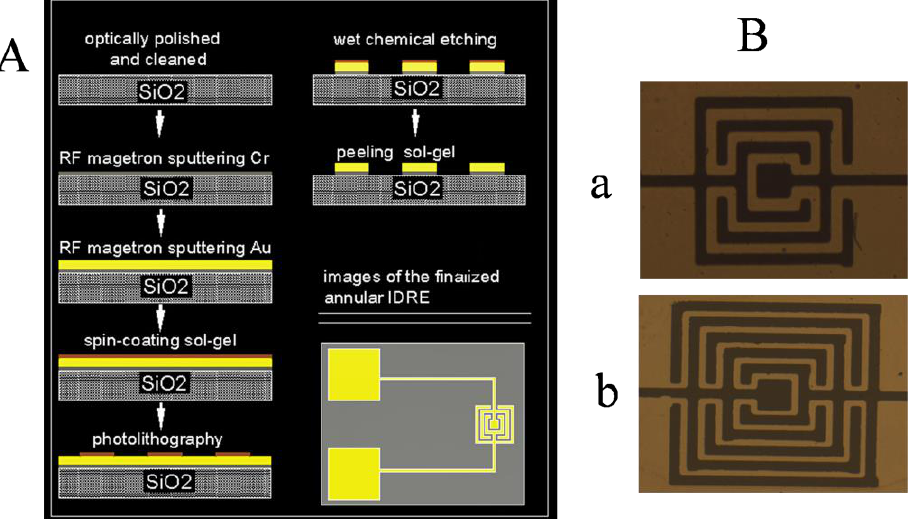
Figure 2. ( A ) Schematic diagram for the manufacture of the annular microelectrode; ( B ) Optical micrograph of the annular microelectrode. Black represents the Au microelectrode and yellow represents gaps or spaces. ( a ) Microelectrode with a 100 µ m finger width and a 100 µ m finger gap; ( b ) Microelectrode with a 100 µ m finger width and a 50 µ m finger gap.